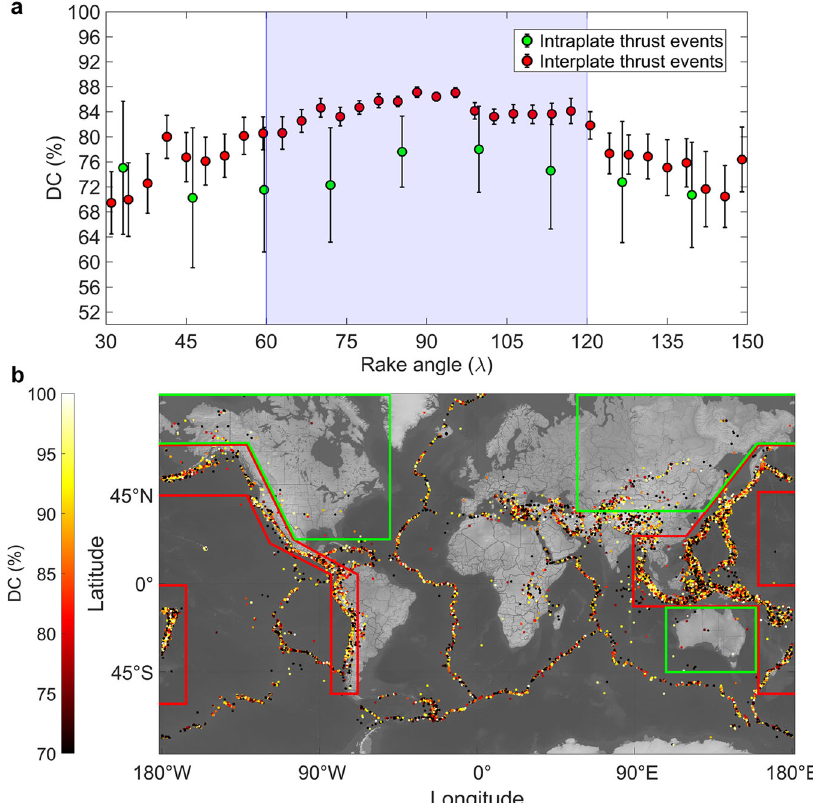
Fig. 6 Double-couple component of the seismic moment tensors in the GCMT catalogue for 5.3 ≤ M w ≤ 7.0 shallow (depth lower than 50 km) thrust- faulting (30° ≤ rake angle ≤ 150°) events (1990 – 2021). The maximum magnitude is limited such that the mean values of magnitudes of the sets of intraplate and interplate events are not statistically different. This choice is needed to avoid a bias in the estimation of average DC values since subduction events reach larger magnitudes than intraplate thrust-faulting events. Intraplate thrusting events (green points, a ) are analysed separately from subduction earthquakes (red points, a ). Error bars stand for 2 σ . Seismic events are selected within the regions highlighted in the map, intraplate earthquakes are those inside the green contours, while interplate are within the red ones ( b ). Thrust-faulting intraplate earthquakes show lower DC components than the events occurring along the subduction zones.